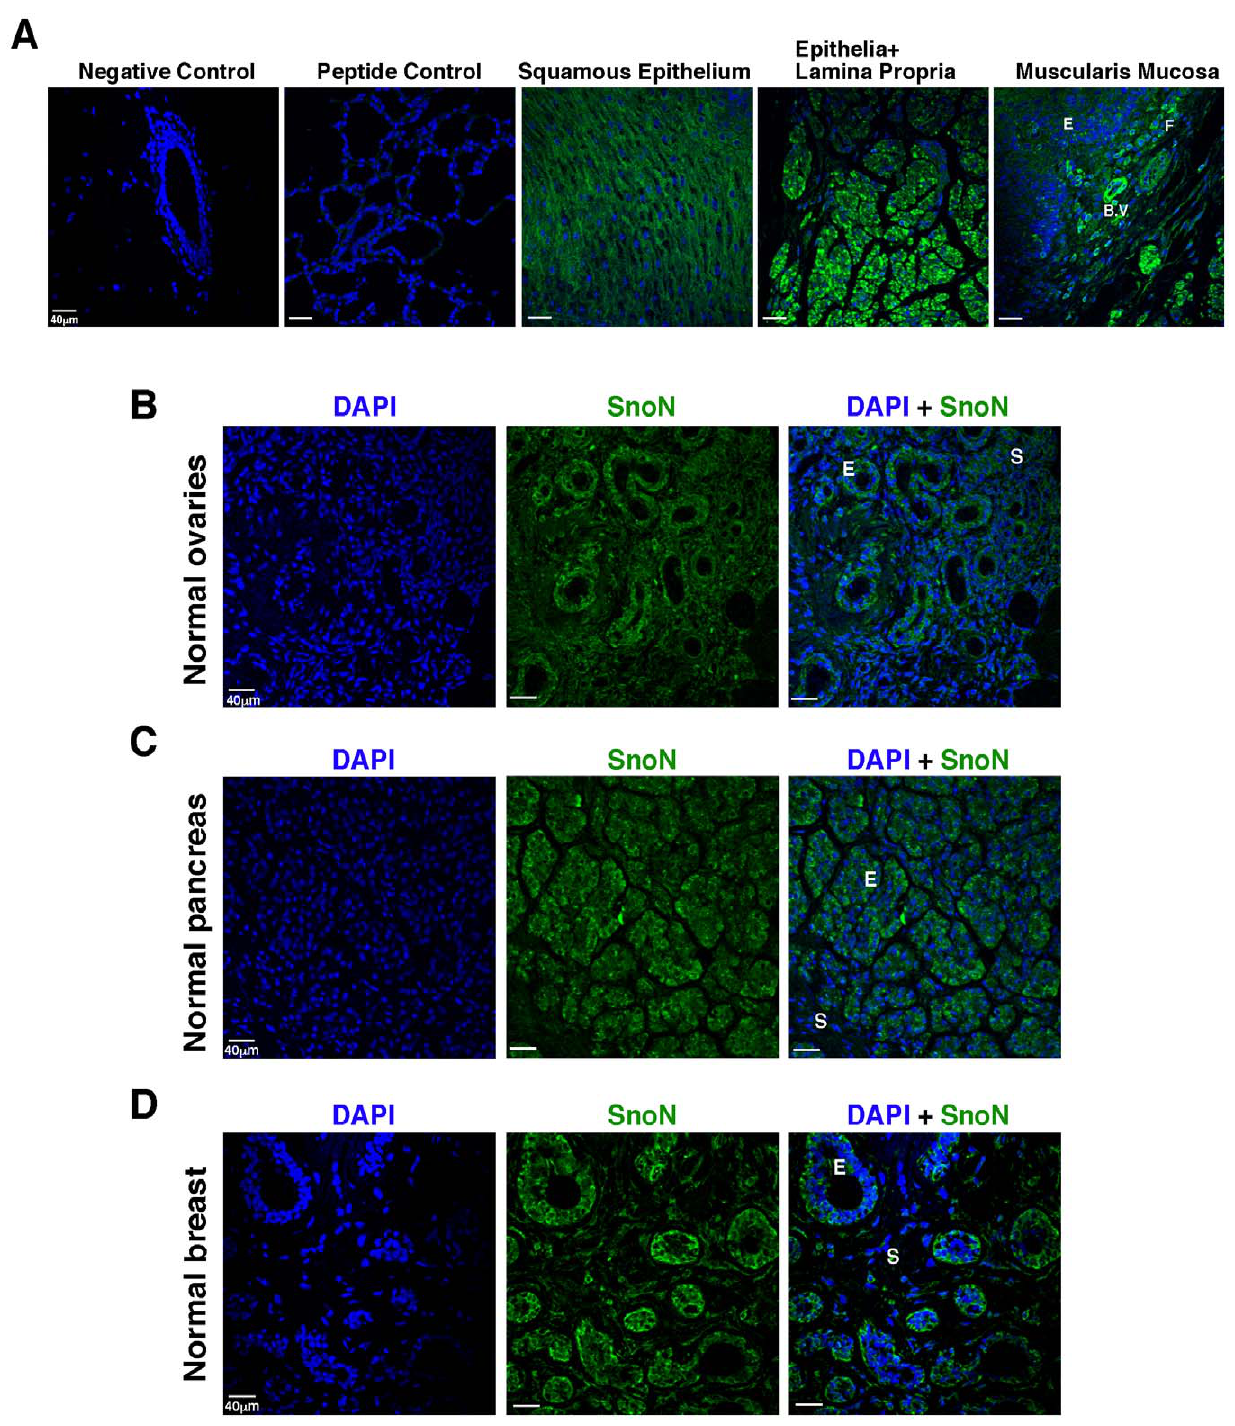
Figure 1. SnoN is expressed in normal mammalian tissues. A, SnoN expression in the normal esophagus, including the suprabasal differentiated squamous epithelial cells, the lamina propria (stroma and connective tissue), and muscularis mucosa (smooth muscle). E: epithelial cells; F: fibroblasts; B.V; blood vessel. Negative control: tissue stained with conjugated secondary antibody alone and without primary antibody. Peptide control: tissue stained with the SnoN peptide competition control. Green: SnoN; blue, DAPI. B, Representative SnoN expression in the normal ovarian tissue. E: follicle epithelial cells; S: stroma. The left panel is DAPI stain alone (blue), the middle panel is SnoN stain alone (green), and the right panel is SnoN (green) plus DAPI (blue) stains. Same is true for figure panels in C-D. C, Representative SnoN expression in the normal pancreas. E: acinar epithelial cells; S:stromal cells of the lobular connective tissue septa. D, Representative SnoN expression in the normal breast. E: epithelial cells of ducts and lobuli; S: stroma.